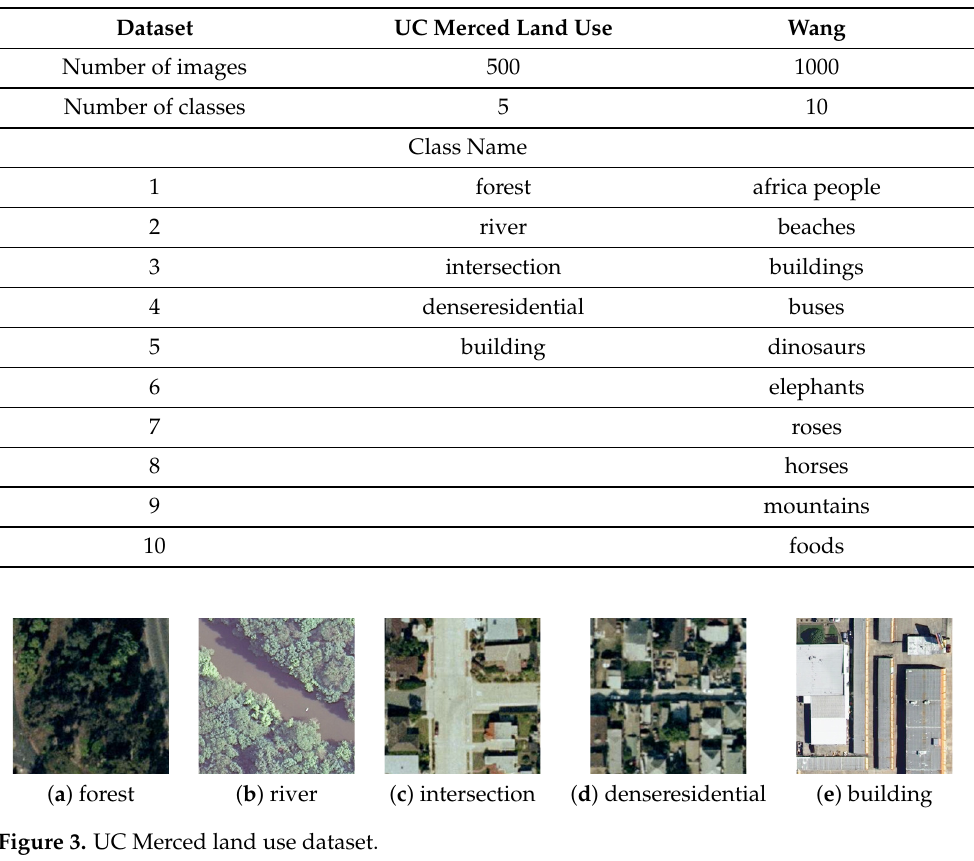
Table 1. Datasets in our experiments.